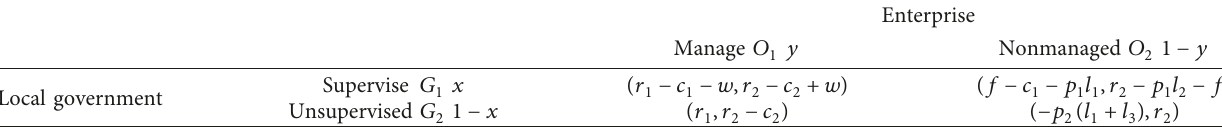
Table 2: Game payment matrix between local government and enterprise.